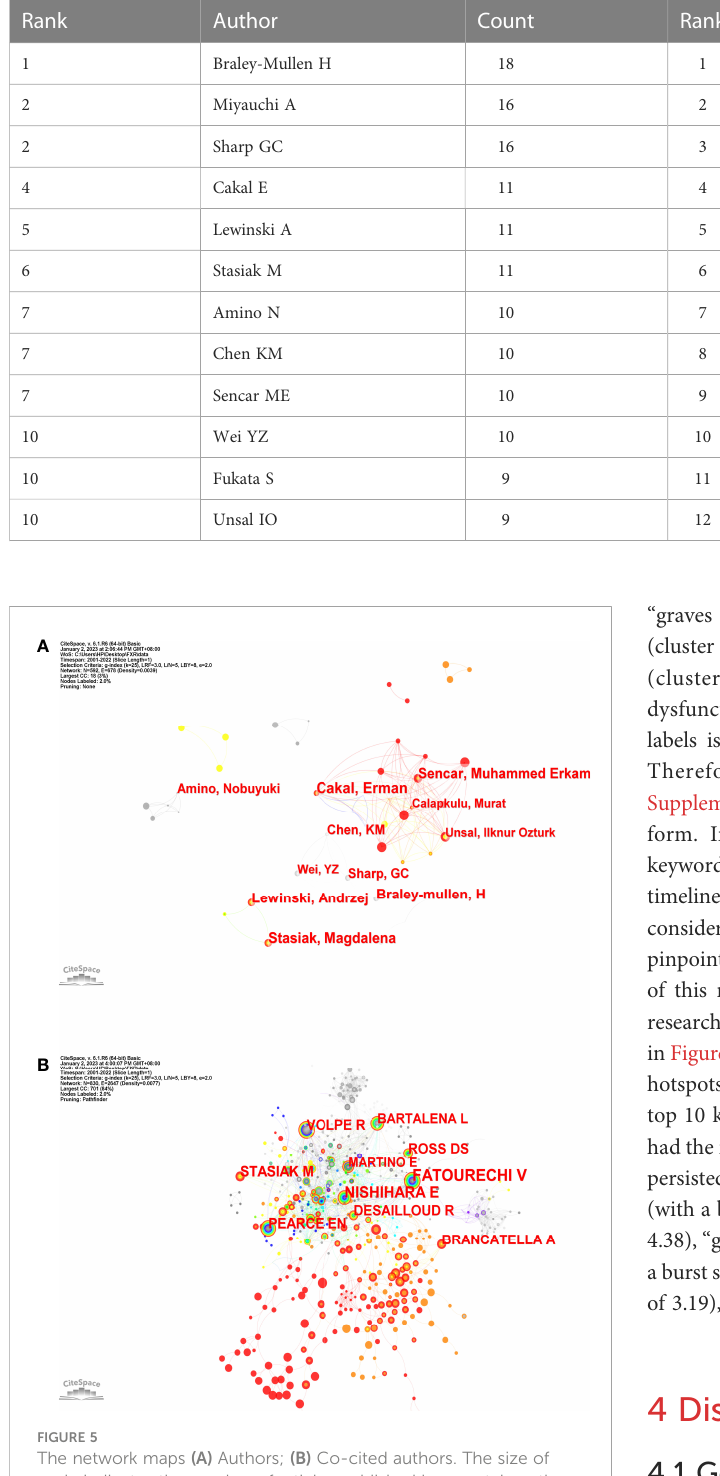
TABLE 2 Top 12 productive authors and co-cited authors in SAT research.